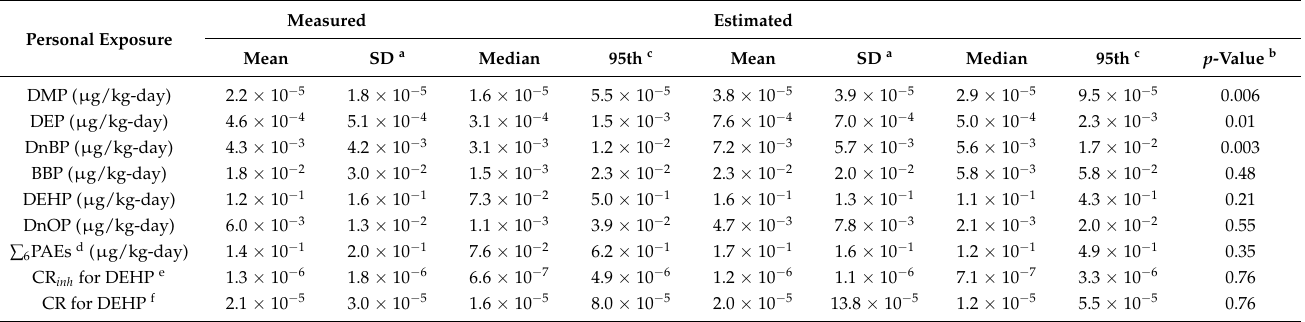
Table 6. Daily intake (DI inh ) of PAEs ( µ g/kg-day) and cancer risks resulting from DEHP exposure via inhalation route measured and estimated personal exposure for